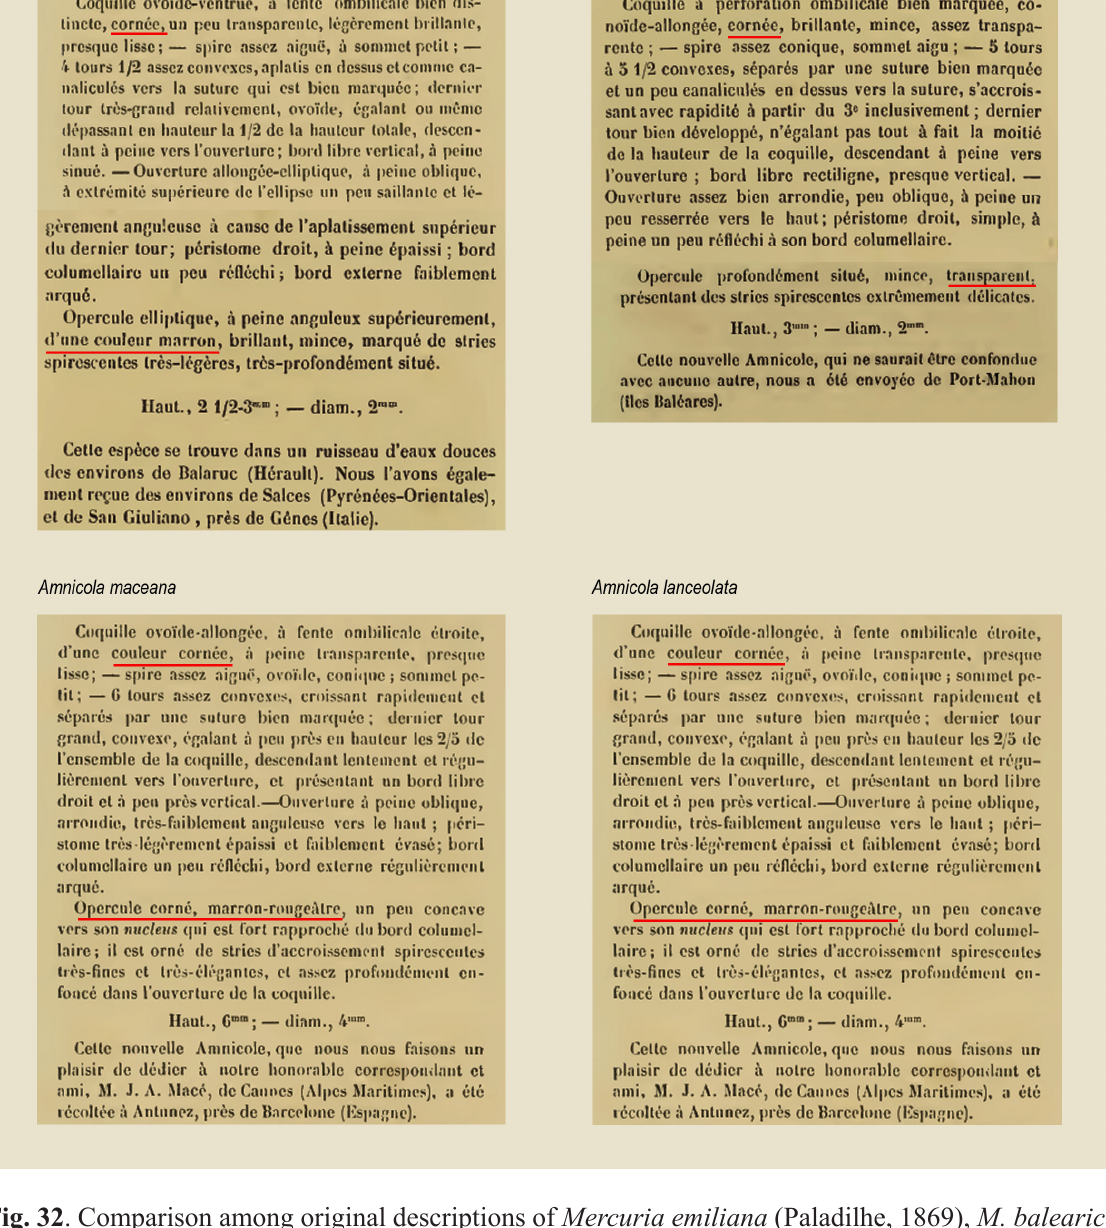
Fig. 32 . Comparison among original descriptions of Mercuria emiliana (Paladilhe, 1869), M. balearica (Frauenfeld, 1865), M. maceana (Paladilhe, 1869) and Amnicola lanceolata Paladilhe, 1869 taken from Paladilhe (1869). Red lines remark the colour of the shells and operculum according to the author’s